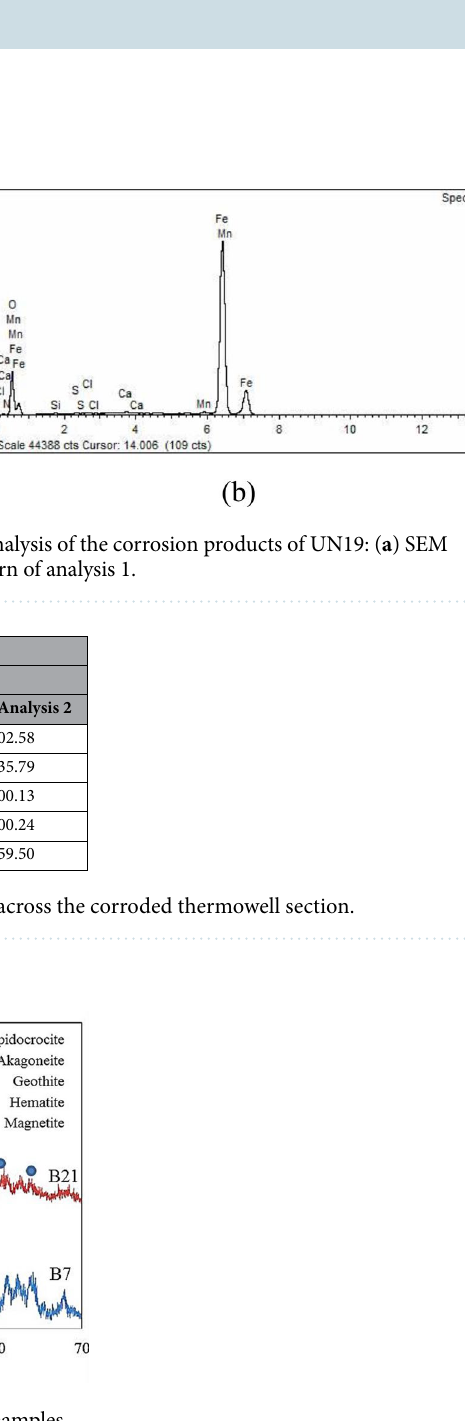
Figure 16. XRD diffraction patterns of selected failed samples.